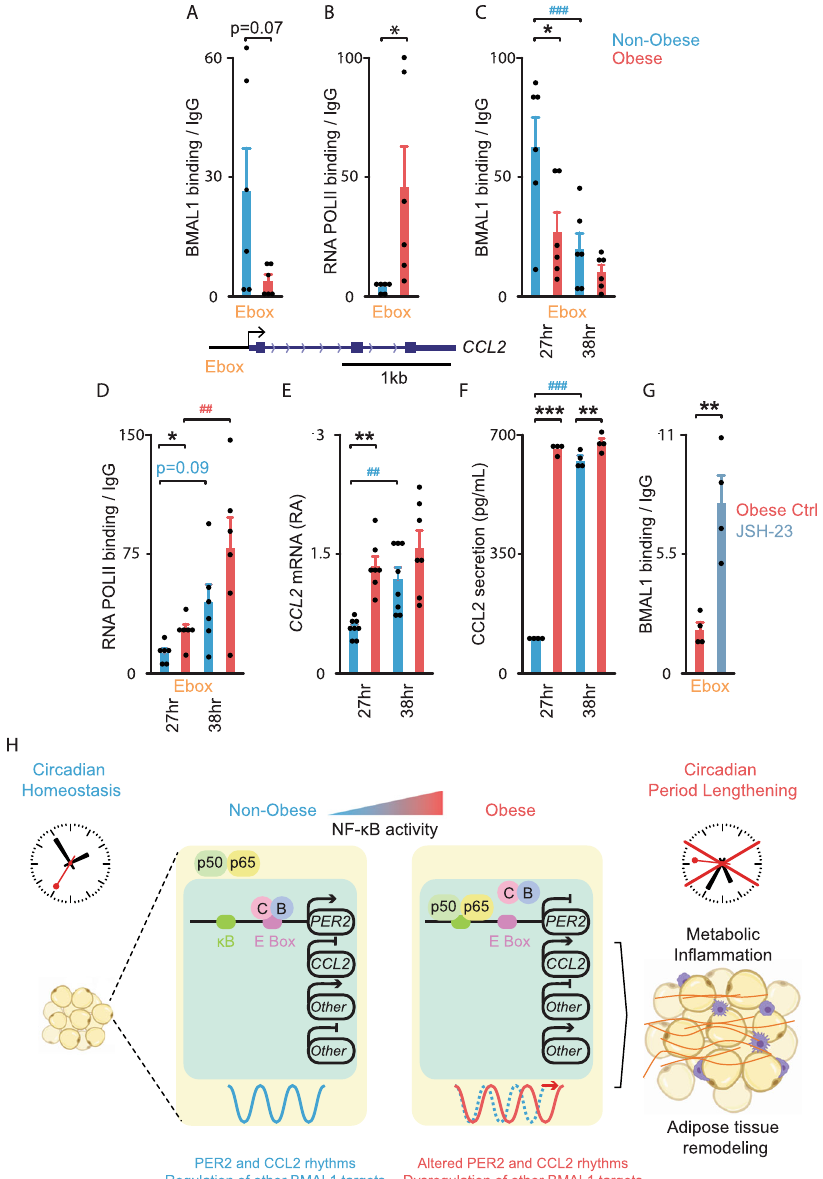
Fig. 4 BMAL1-mediated transcription of CCL2 is altered in adipocyte precursors from obese patients. A – D ChIP analyses of BMAL1 and RNA POLII on CCL2 promoter in non-obese (blue) or obese (red) OAPs, either non-synchronized or harvested 27 h and 38 h post-synchronization. Mean ± SEM in fold enrichment over IgG; n = 6 independent cultures/group from three patients in each non-obese and obese group. E CCL2 gene expression in synchronized non-obese vs. obese OAPs. Mean ± SEM in mRNA RA, n = 8 (non-obese) and n = 7 (obese) independent cultures from four patients in each group. F Measurement of CCL2 secretion in synchronized non-obese vs. obese OAPs, between 27 – 33 h and 38 – 44 h post-synchronization. Mean ± SEM in pg/ ml; n = 4 patients/group. G ChIP analyses of BMAL1 in non-synchronized obese OAPs exposed to 10 μ M JSH-23 (gray) vs. untreated (DMSO, Ctrl, red). Mean± SEM in fold enrichment over IgG; n = 4 independent cultures from two patients. * p < 0.05, unpaired two-tailed t- test ( A , B ); ** p < 0.01, paired two- tailed t- test ( G ); The effect of condition and time was tested by two-way ANOVA followed by post hoc Sidak ’ s test ( C – F ), * p < 0.05, ** p < 0.01, *** p < 0.001 for unpaired measures (non-obese/obese), # p < 0.05, ## p < 0.01, ### p < 0.001 for paired measures (27 h vs. 38 h or 27 – 33 h and 38 – 44 h). H Proposed model of obesity linking circadian clock dysfunction in human omental fat and metabolic in fl ammation. The molecular clock is encoded by transcription – translation feedback loops composed of activators BMAL1 (B) and CLOCK (C) that induce the transcription of repressors, the most important being PER2 . PER2 feeds back to inhibit the forward limb. This process generates a rhythm of ~24 h. In obesity, NF- κ B activity is increased: increased NF- κ B p65 binding prevents BMAL1 binding to PER2 E-box, thereby reducing BMAL1-mediated transcription of PER2 and inducing lengthening of the circadian period. The concomitant decreased BMAL1 binding to CCL2 leads to actively transcribed CCL2 and subsequent upregulated CCL2 secretion. In obesity, increased or decreased BMAL1 binding at other loci was associated with an altered production of the targets ( “ Other ” ; BMAL1 exerting a transactivator/ repressor role, see infra), contributing to metabolic in fl ammation and adipose remodeling (macrophages, purple; fi brosis, red). See also Supplementary Fig.